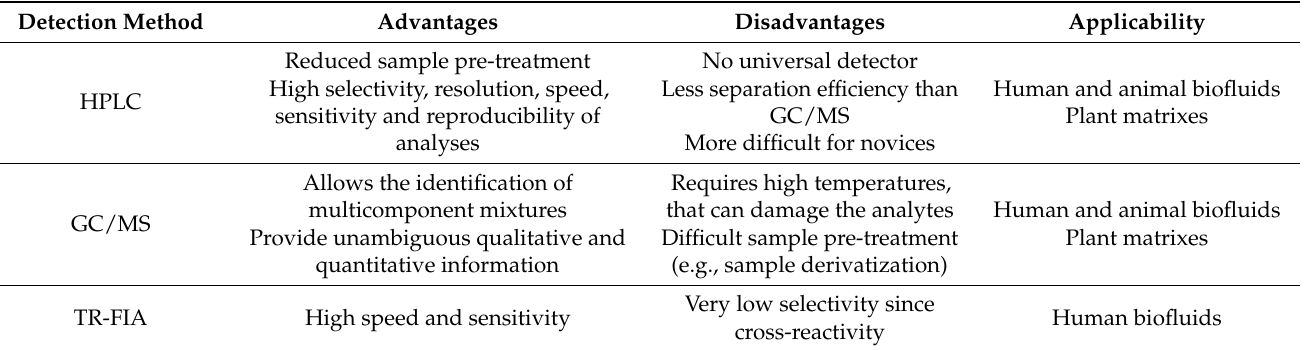
Table 1. Main advantages, disadvantages and applicability of the leading lignans detection